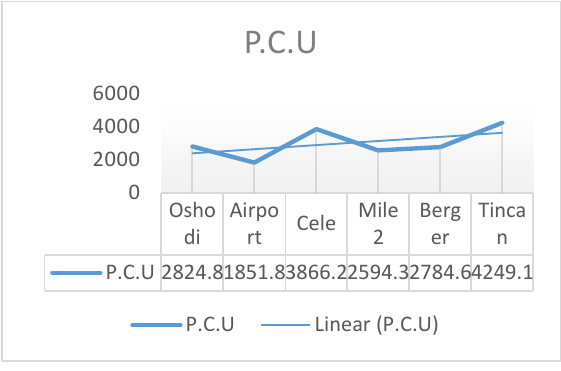
Figure 14: Hourly